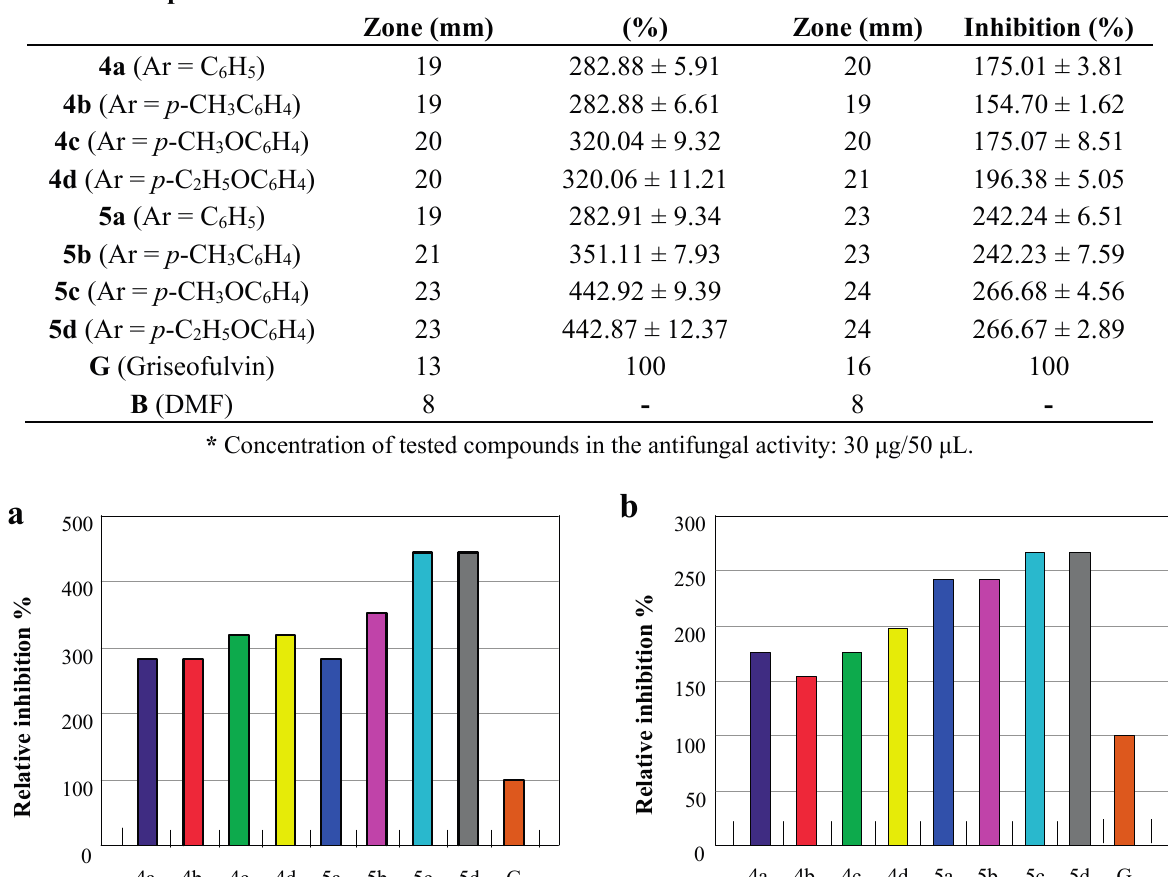
Table 2. Antifungal activity of sydnonyl-substituted thiazolidine derivatives 4a – d , 5a – d . Aspergillus Niger * Compounds